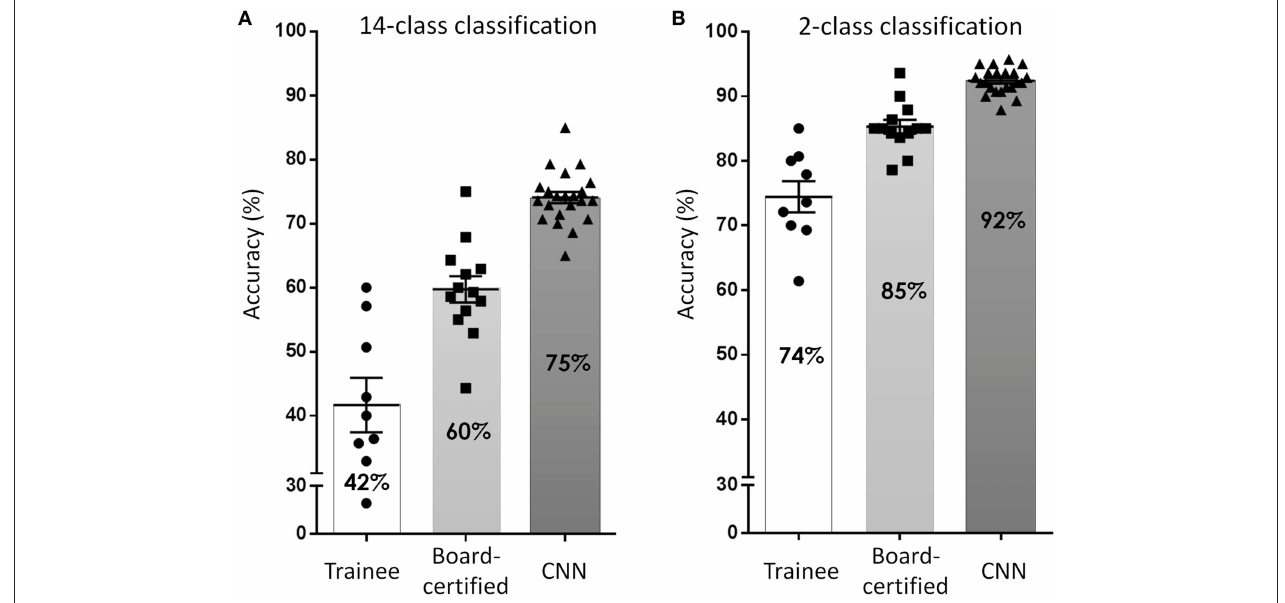
FIGURE 6 | Accuracy of skin tumor classification by our CNN classifier. (A) Result of 14-class classification by dermatology trainees, board-certified dermatologists, and CNN classifier. Adapted from Fujisawa et al. (39). (B) Result of 2-class classification (benign or malignant). In both classification level, the accuracy of CNN surpassed board-certified